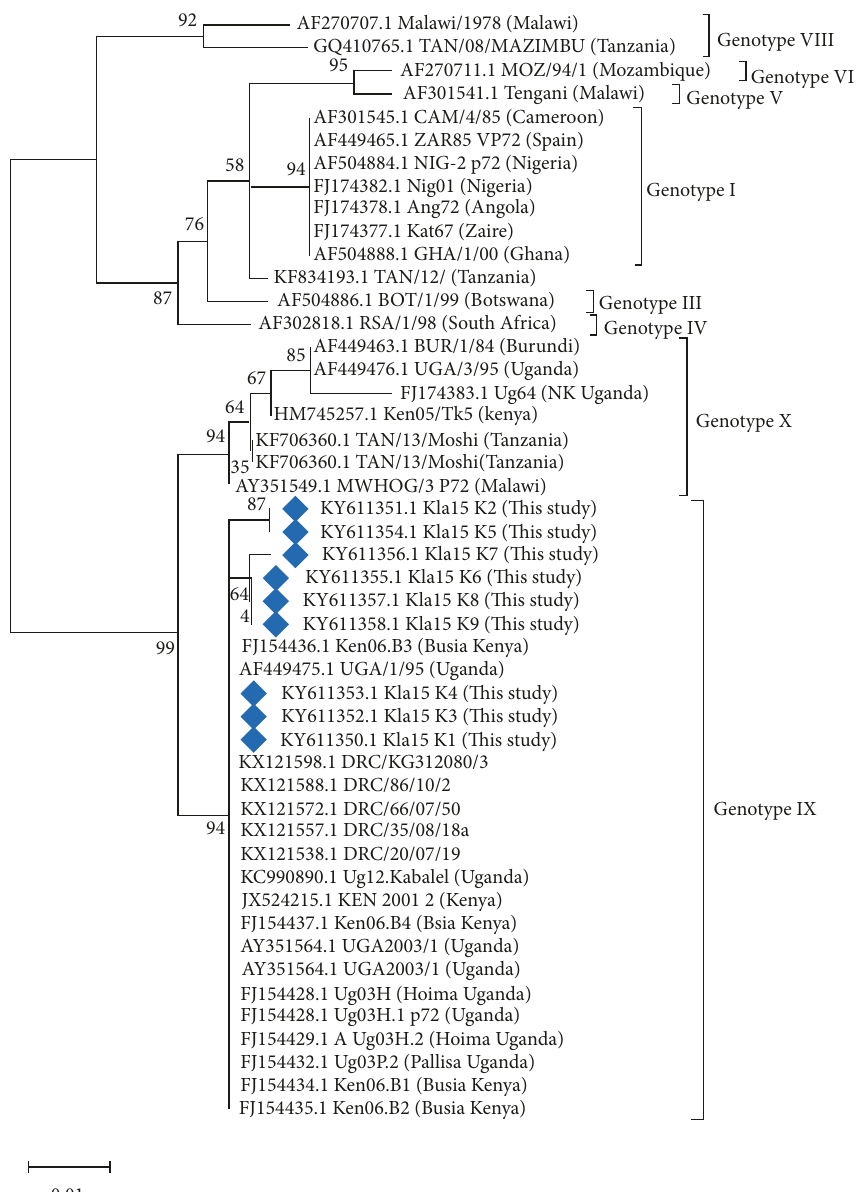
Figure 2: Phylogenetic tree constructed using 9 partial p72 sequences from this study and 39 from the representative genotypes from the GenBank. The evolutionary history was inferred by the maximum likelihood method based on the Kimura 2-parameter model [22]. The p72 sequences characterized from this study are denoted by Blue